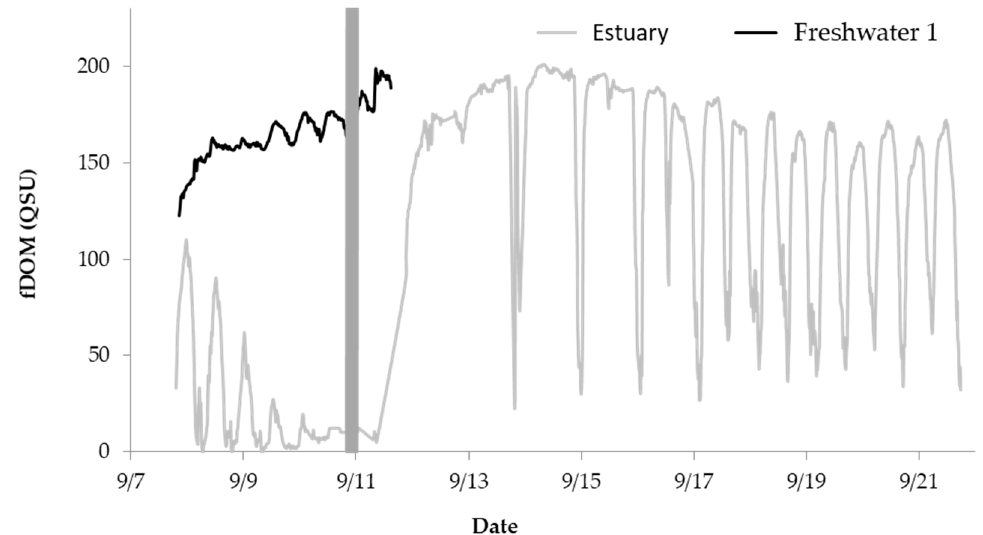
Figure 5. fDOM concentrations at the estuary and freshwater 1 sonde locations. The sonde located at the freshwater 1 site malfunctioned after the storm, so only 4 days of data were successfully recorded.